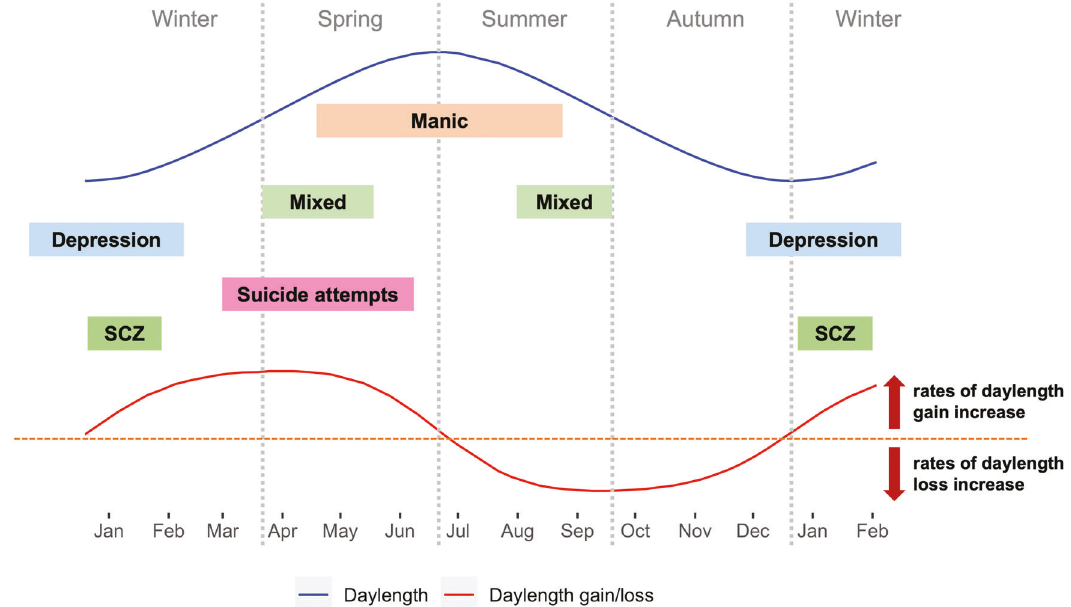
Fig. 1 Peaks of psychiatric symptoms in relationships to daylength and day-to-day daylength gain/loss. Blue curve: daylength changes throughout the year in the northern hemisphere. Red curve: day-to-day daylength gain/loss throughout the year in the northern hemisphere. Red dashed line: threshold indicating there is no change in daylength compared to the previous day. Curve above the dashed red line indicates days that have longer daylength than the previous day, while curve below the dashed red line indicates days that have shorter daylength than the previous day. The peak around late March is the day with greatest daylength gain, the nadir around late September is the day with greatest daylength loss. Mixed: mixed symptoms in bipolar disorders; SCZ: Schizophrenia hospitalizations & fi rst-episode